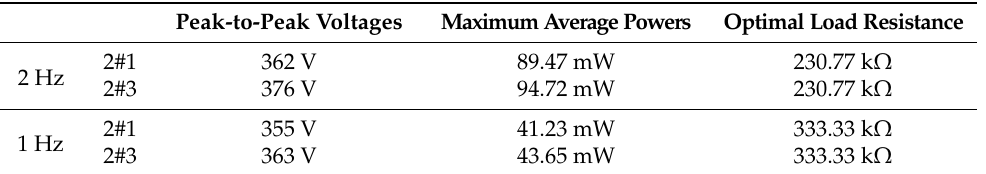
Table 4. Output electric parameters from 2#1 and 2#3 PZT4 patches on unimorph PCSs in different frequency of exerted force ( F = 500 N, L = 33.5 mm).